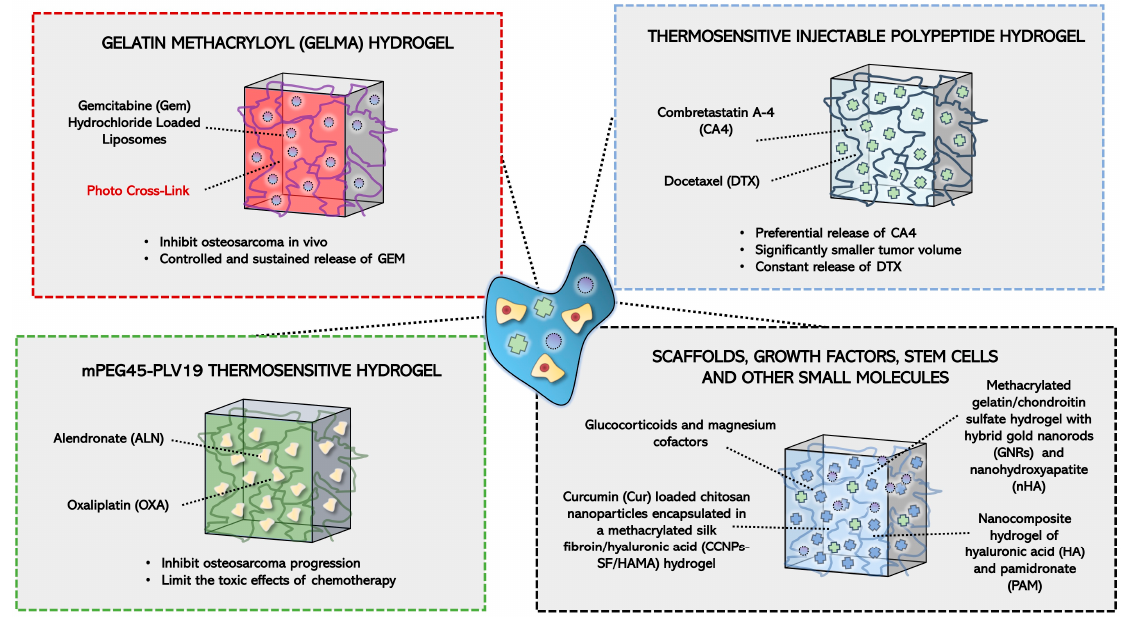
Figure 5. Schematic of hydrogel combination drug therapies, commonly administered to induce slow drug release and cancer cell death in osteosarcoma [81,82,84,92–94]. This figure was generated using the Servier Medical Art. Servier Medical Art is licensed under a Creative Commons A tt ribu- tion 3.0 Unported License [76].